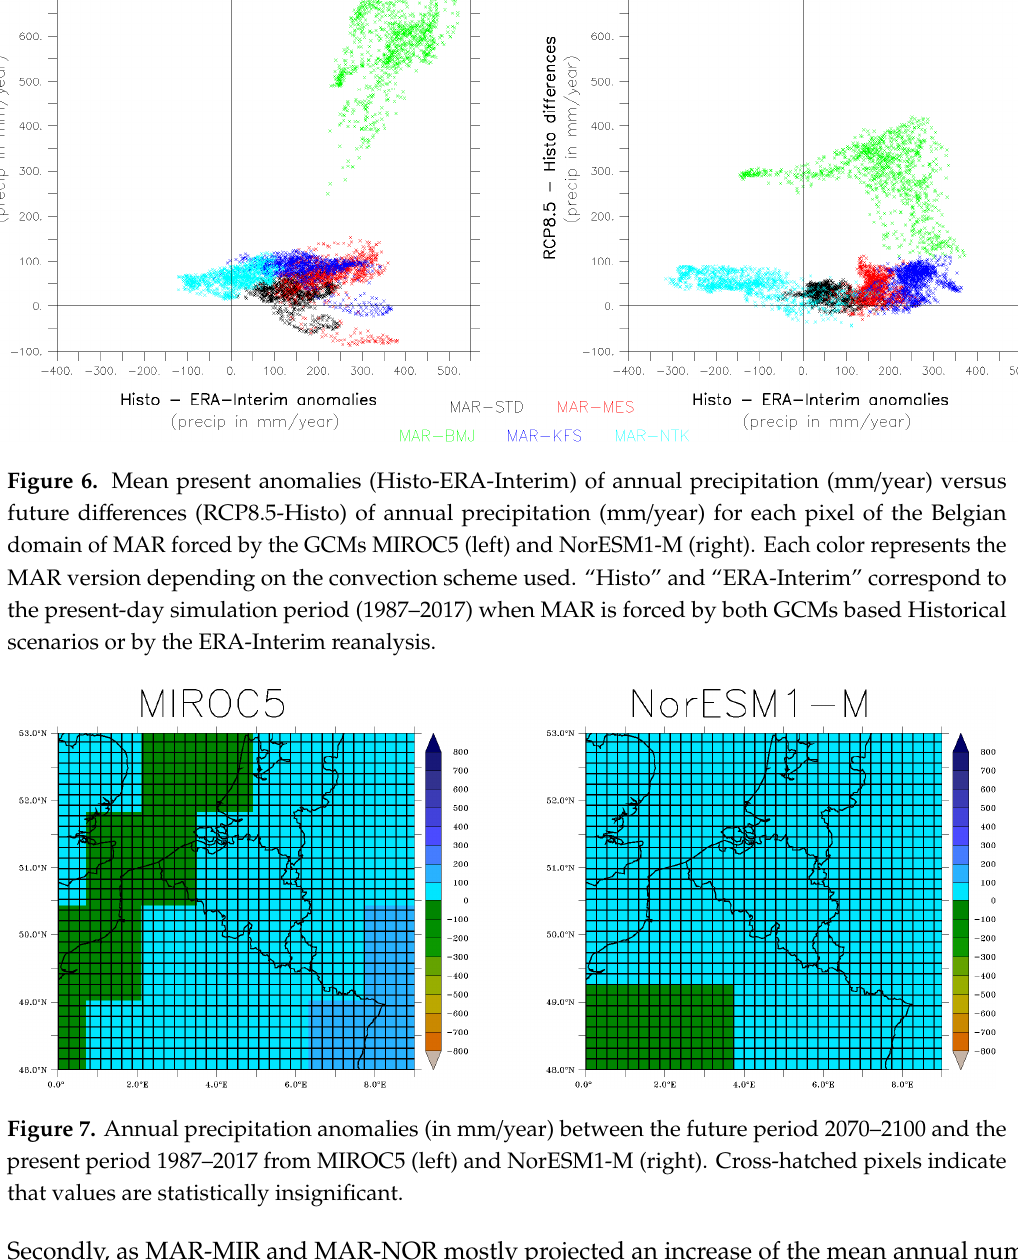
Figure 7. Annual precipitation anomalies (in mm/year) between the future period 2070–2100 and the present period 1987–2017 from MIROC5 (left) and NorESM1-M (right). Cross-hatched pixels indicate that values are statistically insignificant.